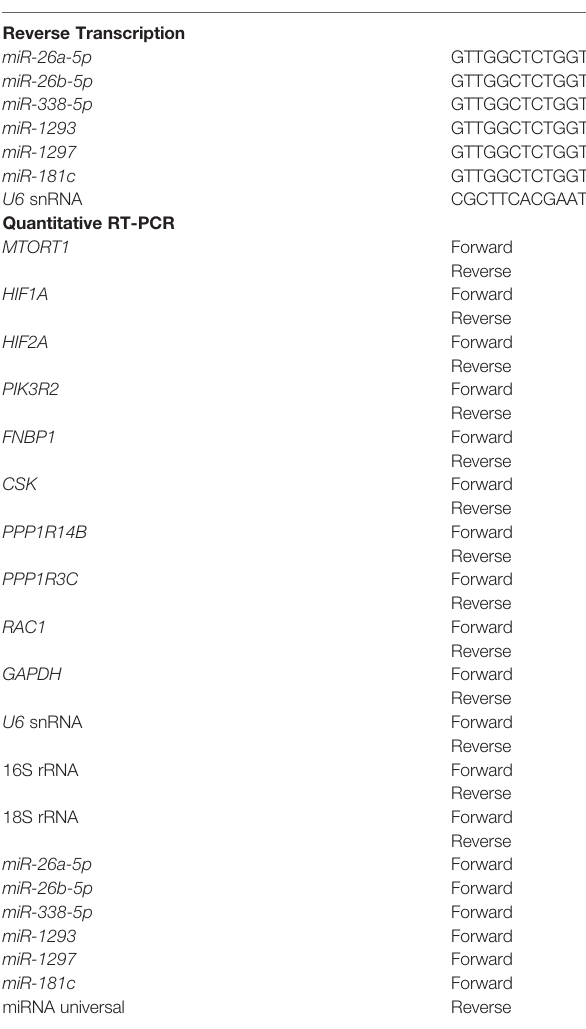
TABLE 1 | The primers for reverse transcription and quantitative RT-PCR. Gene/miRNA Primer Sequence (5 ’ to 3 ’